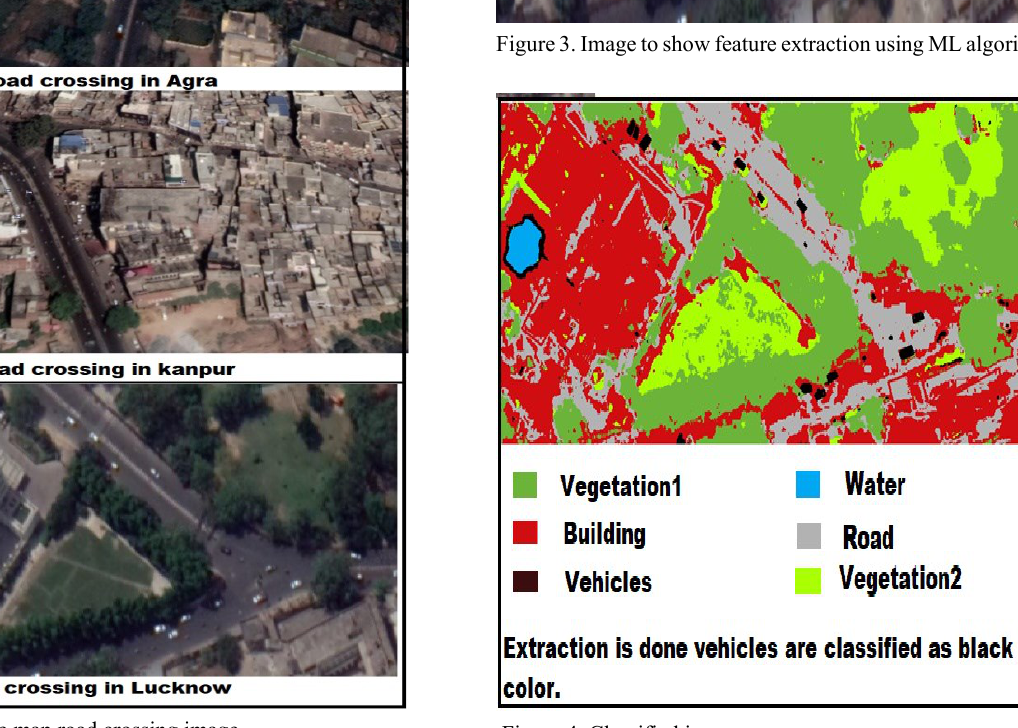
Figure 4. Classified